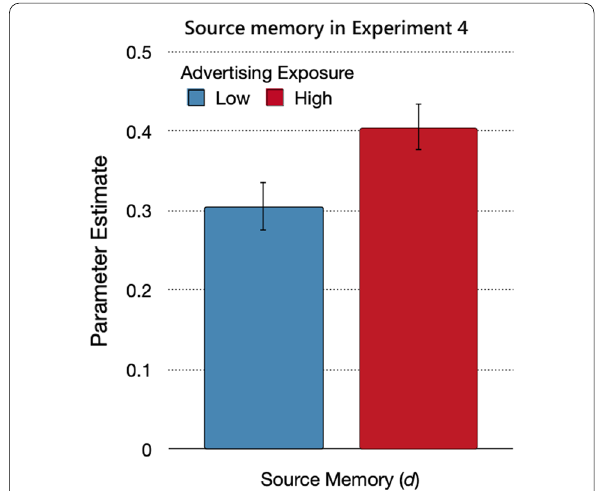
Fig. 10 Source memory in Experiment 4. Note : Parameter estimates of the source memory parameter d , reflecting the probability of correctly remembering the source of the statements from the advertising and trustworthy sources, as a function of advertising exposure (low, high). The error bars reflect standard errors